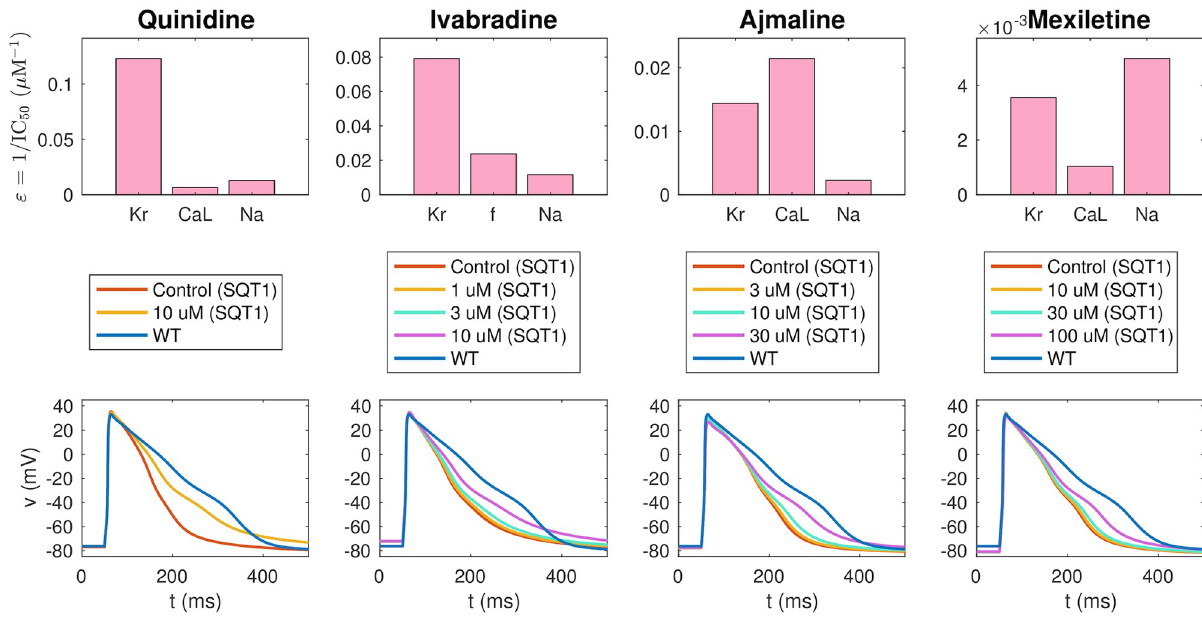
Fig 8. Result of the inversion procedure applied to data for the drugs quinidine, ivabradine, ajmaline and mexiletine from [9, 11]. Upper panel: Predicted drug effect on individual ion channels in the form of ε -values returned by the inversion procedure. Lower panel: Action potentials of the fitted SQT1 hiPSC-CM models in the control case and for doses of each drug. For comparison, we also show the action potential of the WT hiPSC-CM model. Action potential characteristics of the fitted models in the lower panel are compared to data from [9, 11] in Fig 7. Data used in this figure can be found in S1 Data.